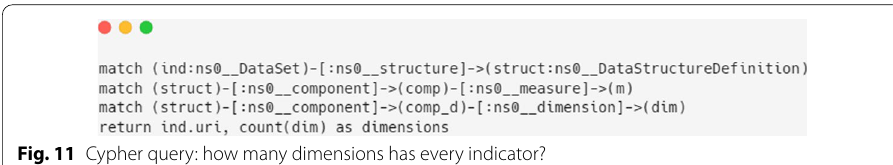
Fig. 11 Cypher query: how many dimensions has every indicator?